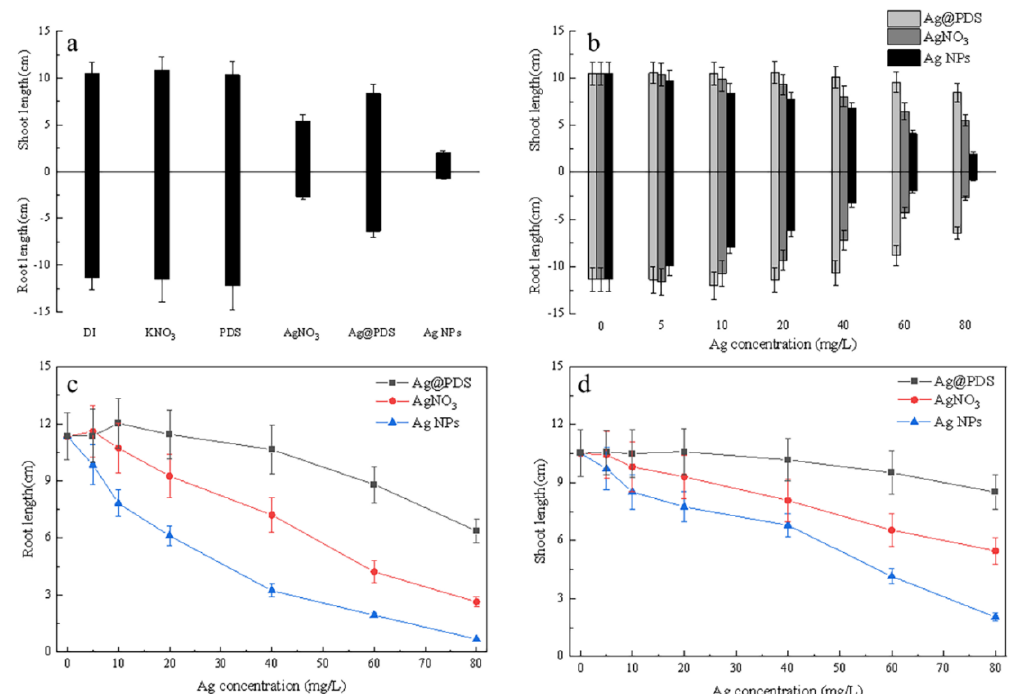
Figure 3. Effect of Ag@PDS, AgNO 3 , and AgNPs on the L. multiflorum root ( a , c ) and shoot ( b , d ) length after 7 days of exposure ( p ≤ 0.05).